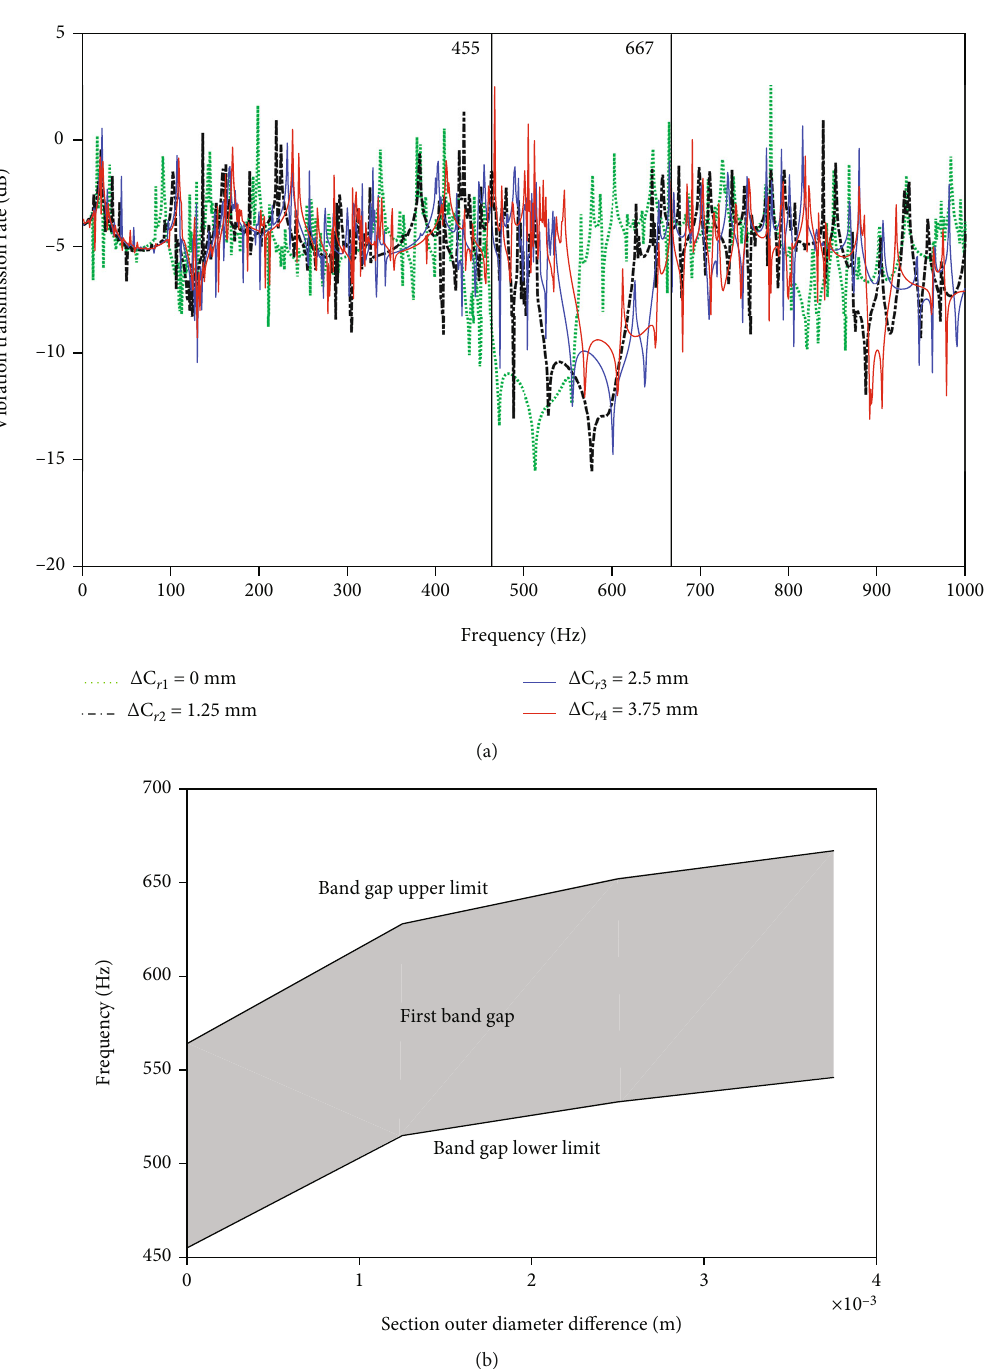
Figure 11: Corresponding to the change of the section outer diameter di ff erence: (a) vibration transmission rate of node R ; (b) the fi rst band